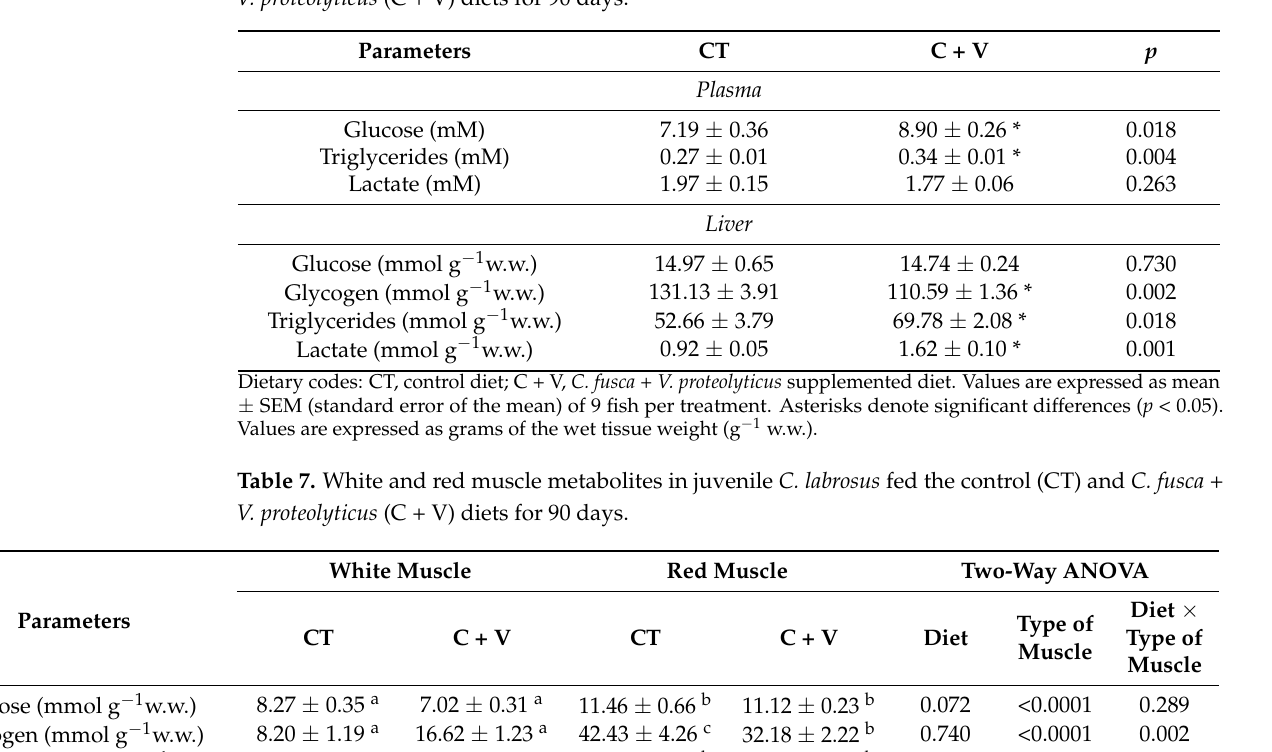
Table 6. Plasma and liver metabolites in juvenile C. labrosus fed the control (CT) and C. fusca + V. proteolyticus (C + V) diets for 90 days.